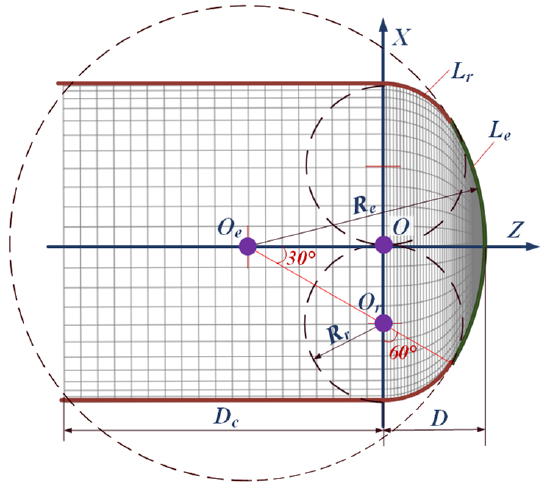
Figure 1. Geometric schematic diagram of the axial longitudinal section profile of DACT.